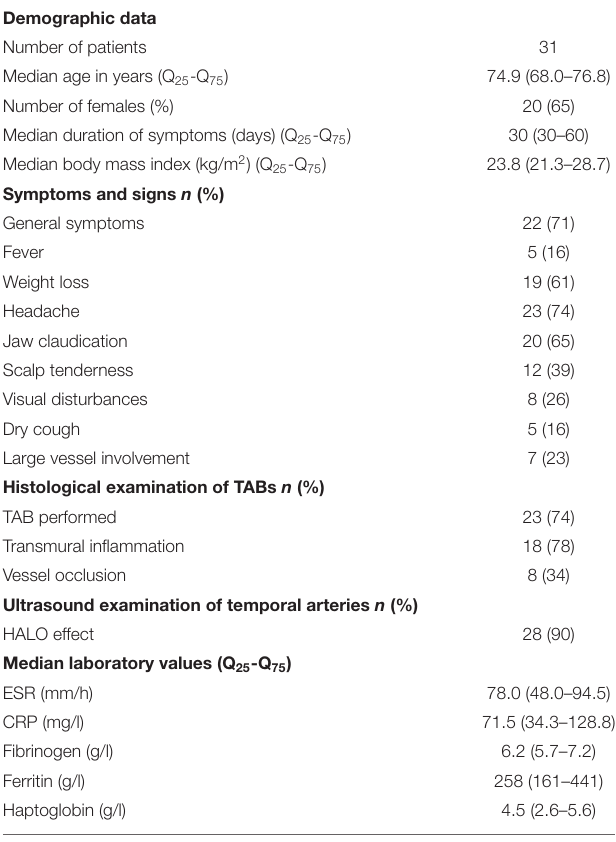
TABLE 1 | Demographics, clinical and laboratory data of therapy-naïve GCA patients at baseline